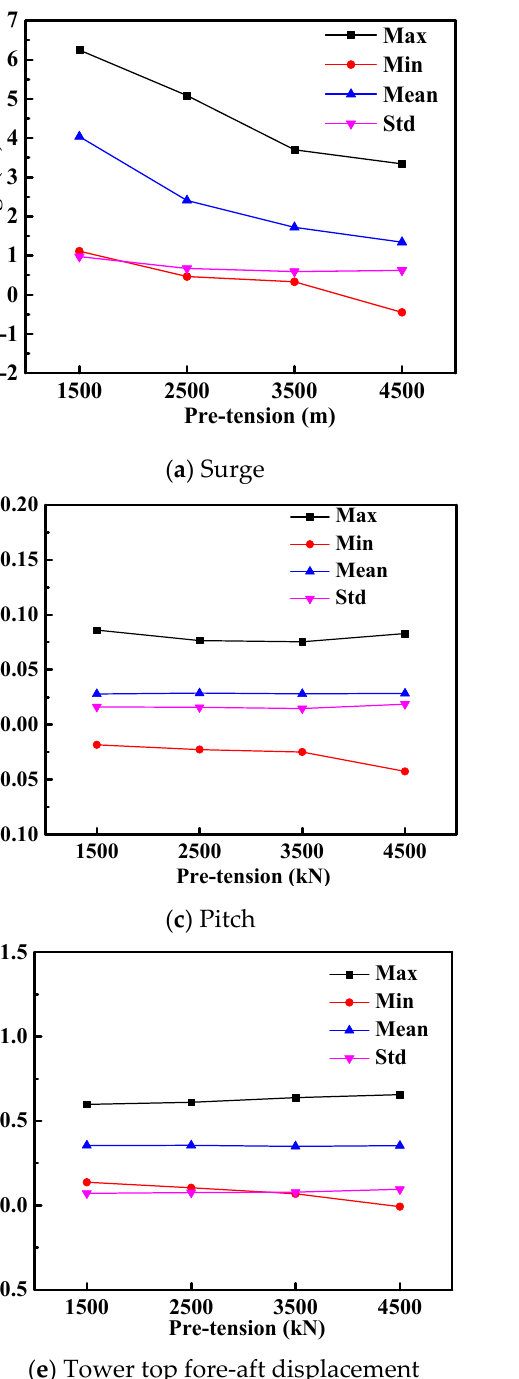
Figure 12. Statistics of platform motion, tower fore-aft displacement, tension of tether 1# in different pretension conditions.